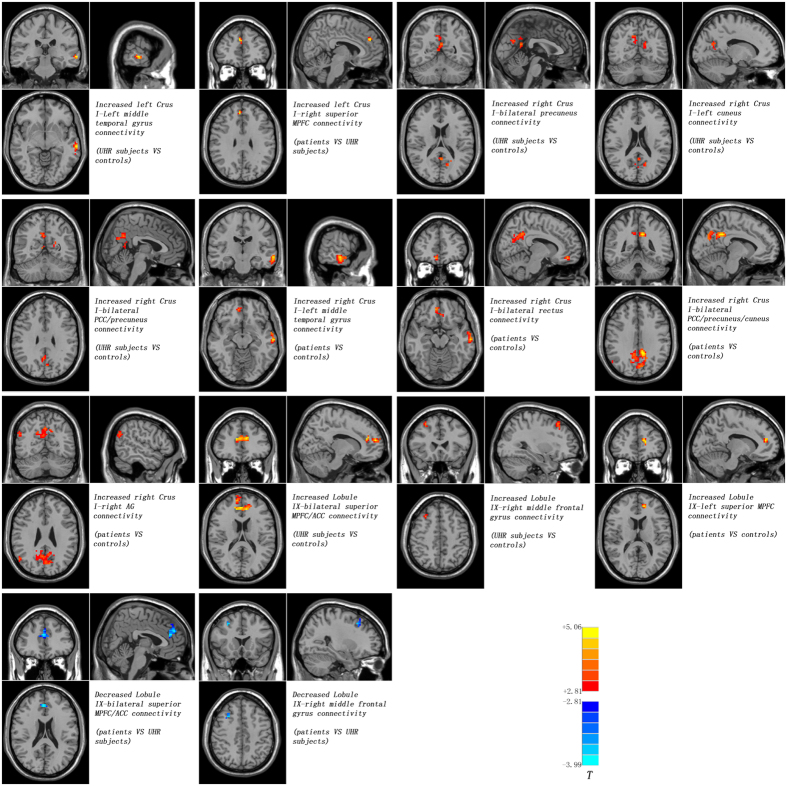
Abnormal cerebellar - DMN connectivity between groups.Red and blue denote increased and decrease FC values. Color bar indicates post-hoc t values. DMN = default mode network, MPFC = medial prefrontal cortex; PCC = posterior cingulate cortex; AG = angular gyrus; ACC = anterior cingulate cortex.